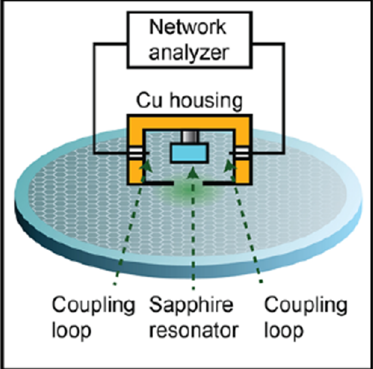
Figure 2. Schematic of a scanning dielectric resonator system in which the dielectric resonator is housed in a conducting box, with an aperture through which the fringing field extends (see